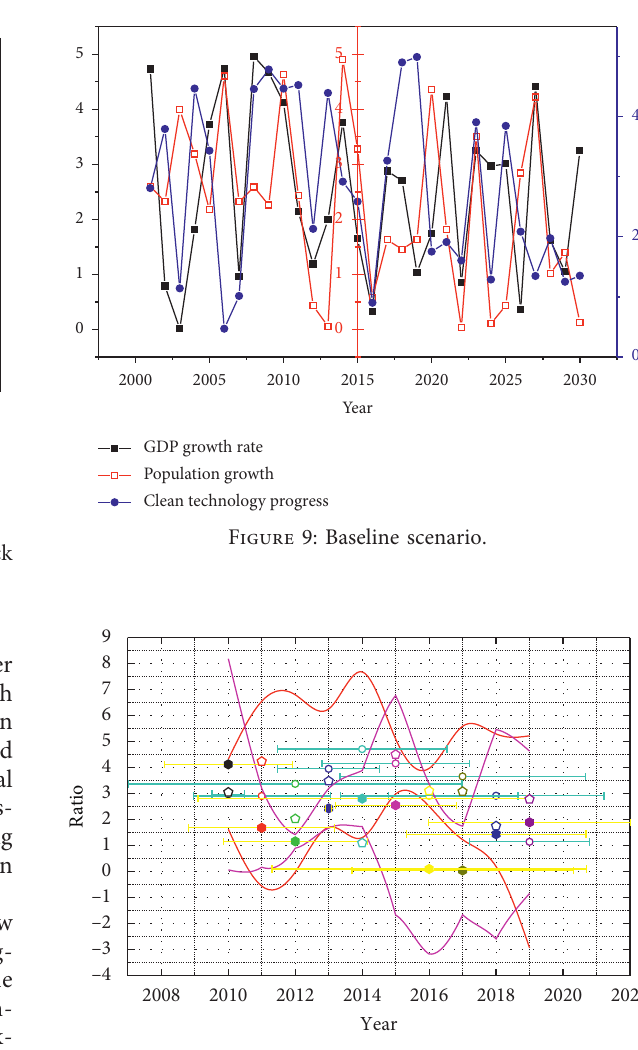
Figure 10: Comparison of the share of the total output of four energy types under different policy